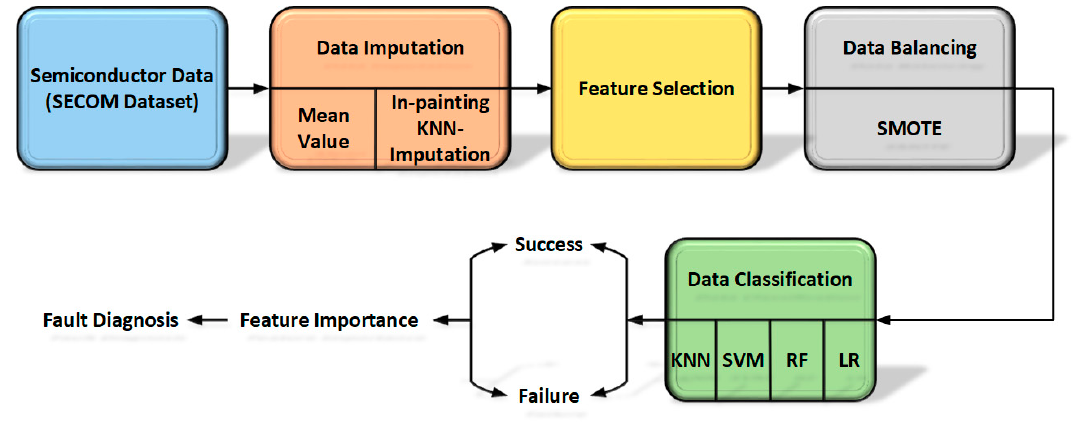
Figure 1. Overview of the diagnosis system architecture.